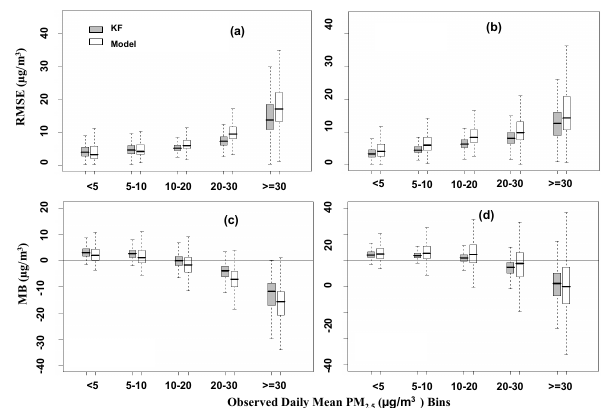
Fig. 11. RMSE (a and b) and MB (c and d) values over observed daily mean PM 2.5 concentration (µg/m 3 ) bins for the raw model and the KF bias-adjusted forecasts. The sample sizes for each bin from small to large are 28203, 17526, 19855, 6855, 2716 (Warm Season) and 34072, 36402, 30697, 6771, 2502 (Cool Season).